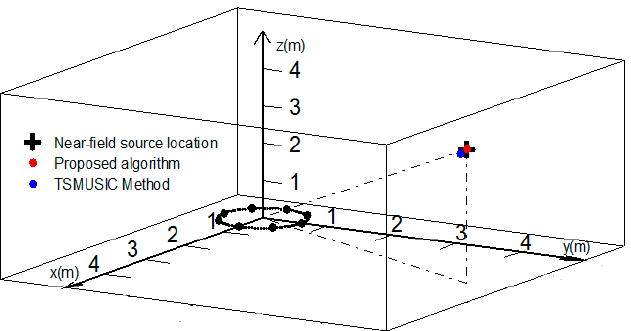
Figure 6. Positioning result of the near-field source (SNR = 20 dB).